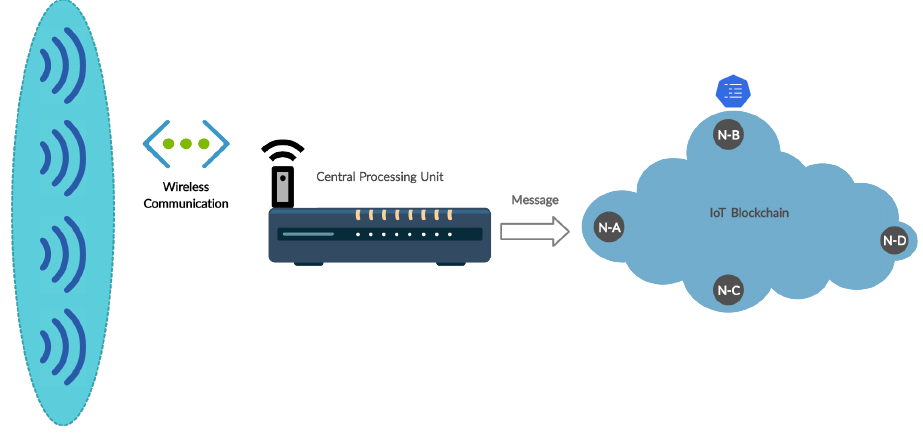
Figure 2. Blockchain for IoT wireless sensor